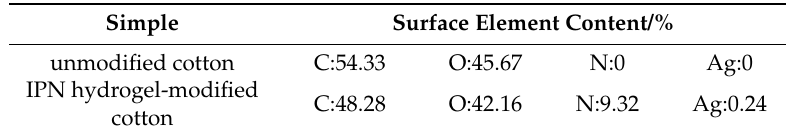
Table 1. The elements content on IPN hydrogel-modified cotton from EDS.